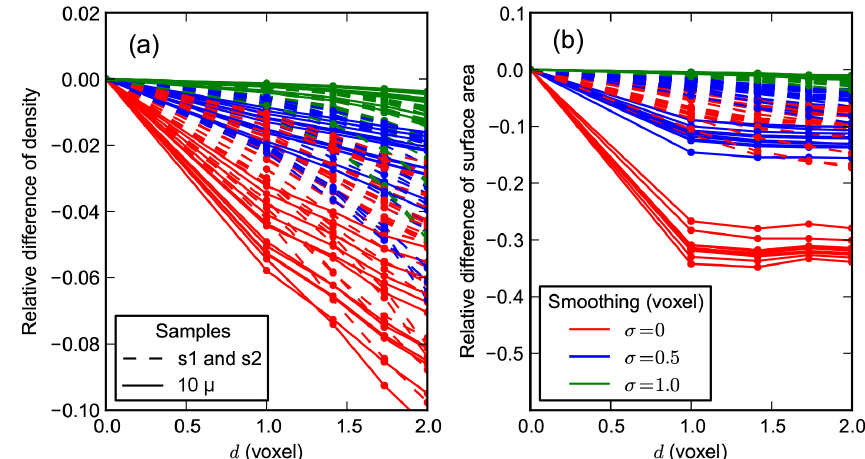
Figure 12. Sequential filtering segmentation: relative variations of density (a) and surface area (b) as a function of the morphological filter size d for different values of the Gaussian filter size σ . The legends apply to both subplots.